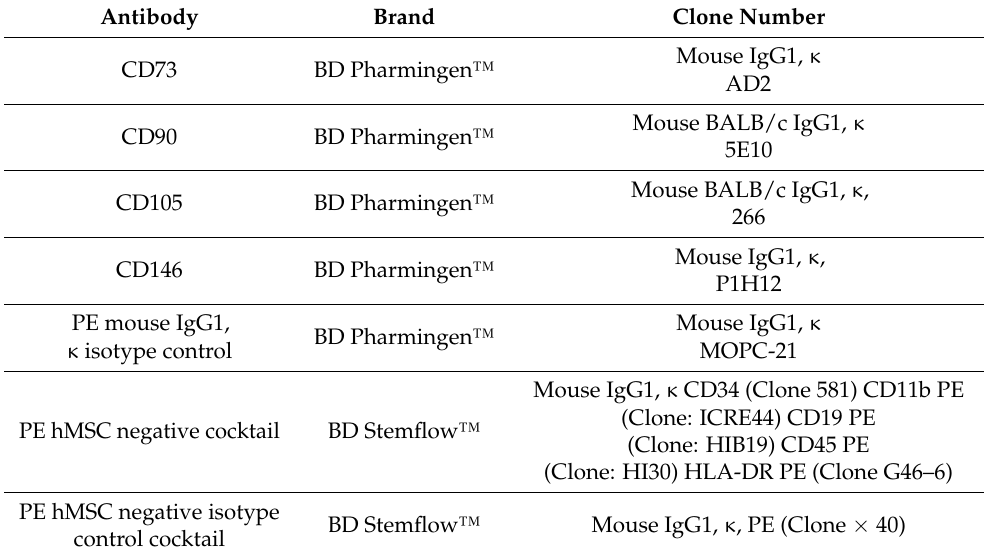
Table 1. Antibodies used for flow